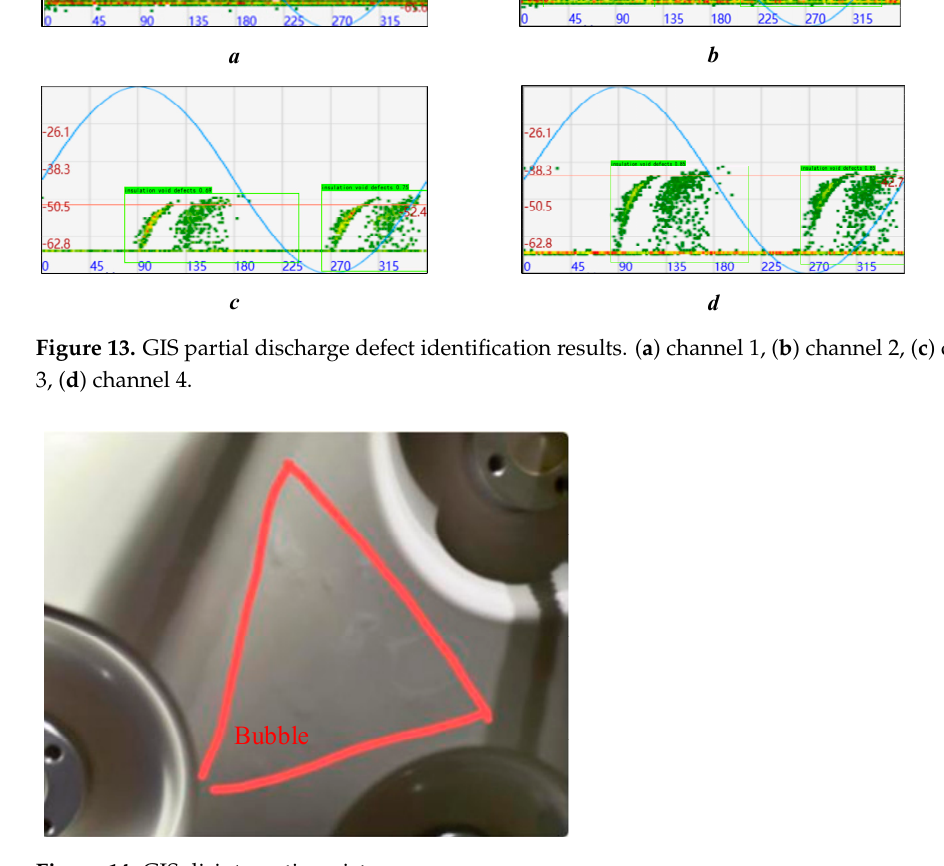
Figure 14. GIS disintegration pictures.